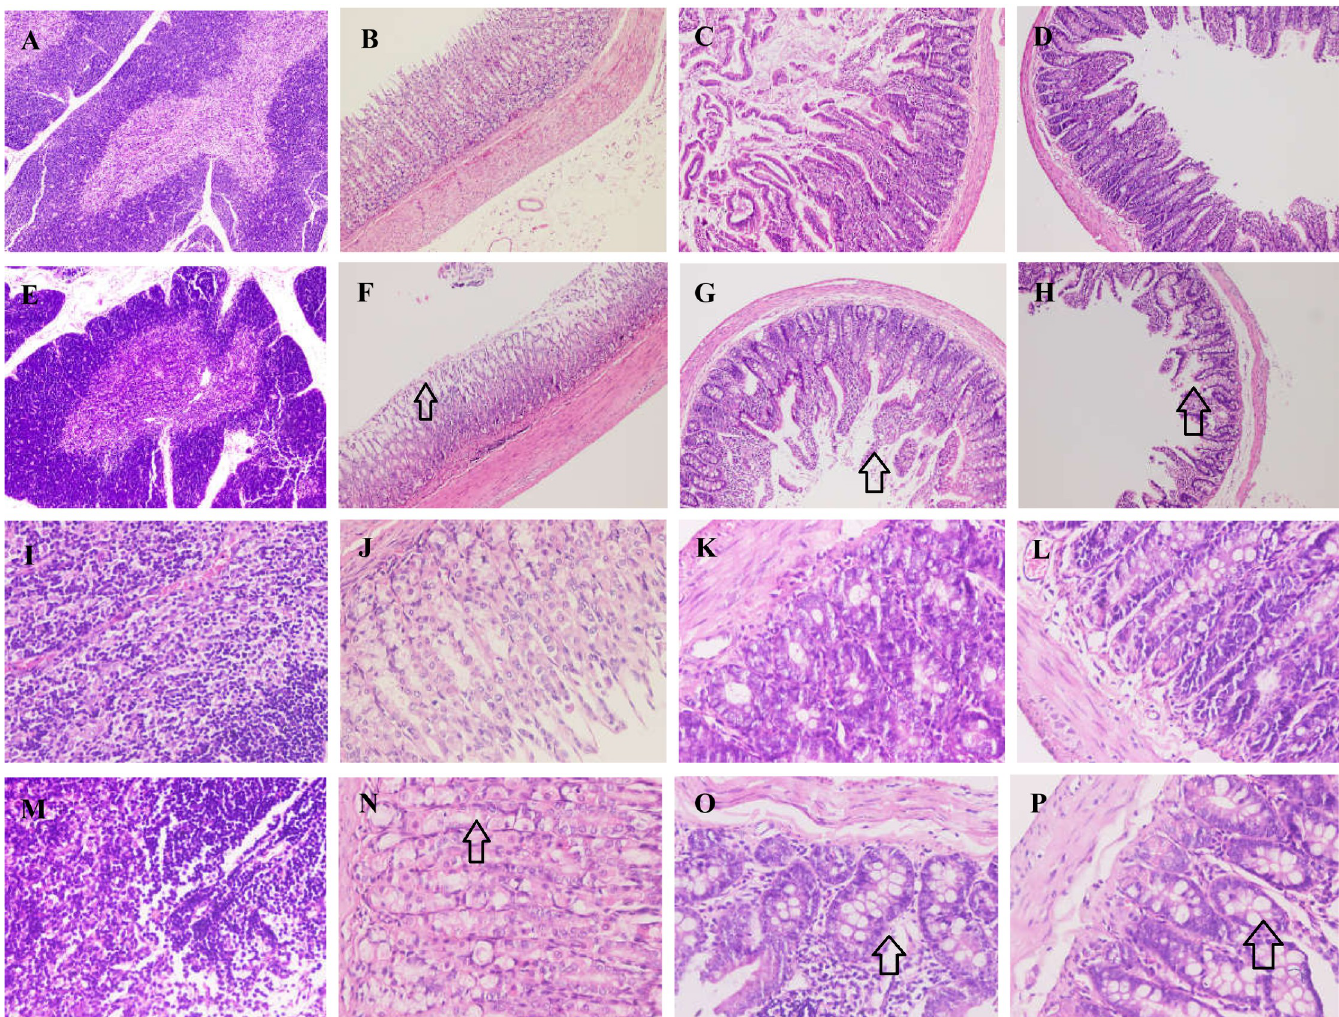
Fig 12. Histological examination of the thymus, stomach, duodenum, and ileum sections. Organ sections were stained with hematoxylin-eosin (HE). The thymocytes increased in the Uox -/- rats’ thymus (E and M), while the villi of the gastric mucosa in the Uox -/- rats’ stomach (F and N), duodenum (G and O), and ileum (H and P) were shortened (the black arrow in F, G, and H) and swollen (the black arrow in N, O, and P). A, the thymus of the wild-type rat; B, the stomach of the wild-type rat; C, the duodenum of the wild-type rat; D, the ileum of the wild-type rat; E, the thymus of the Uox -/- rat; F, the stomach of the Uox -/- rat; G, the duodenum of the Uox -/- rat; H, the ileum of the Uox -/- rat; I, the thymus of the wild-type rat; J, the stomach of the wild-type rat; K, the duodenum of the wild-type rat; L, the ileum of the wild-type rat; M, the thymus of the Uox -/- rat; N, the stomach of the Uox -/- rat; O, the duodenum of the Uox -/ - rat; and P, the ileum of the Uox -/- rat. Picture(A-H)